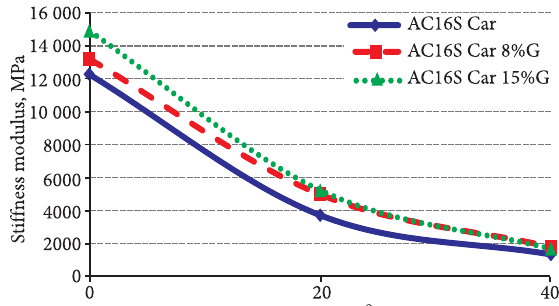
Fig. 1. Variation of the stiffness modulus of the carbonate samples with temperature